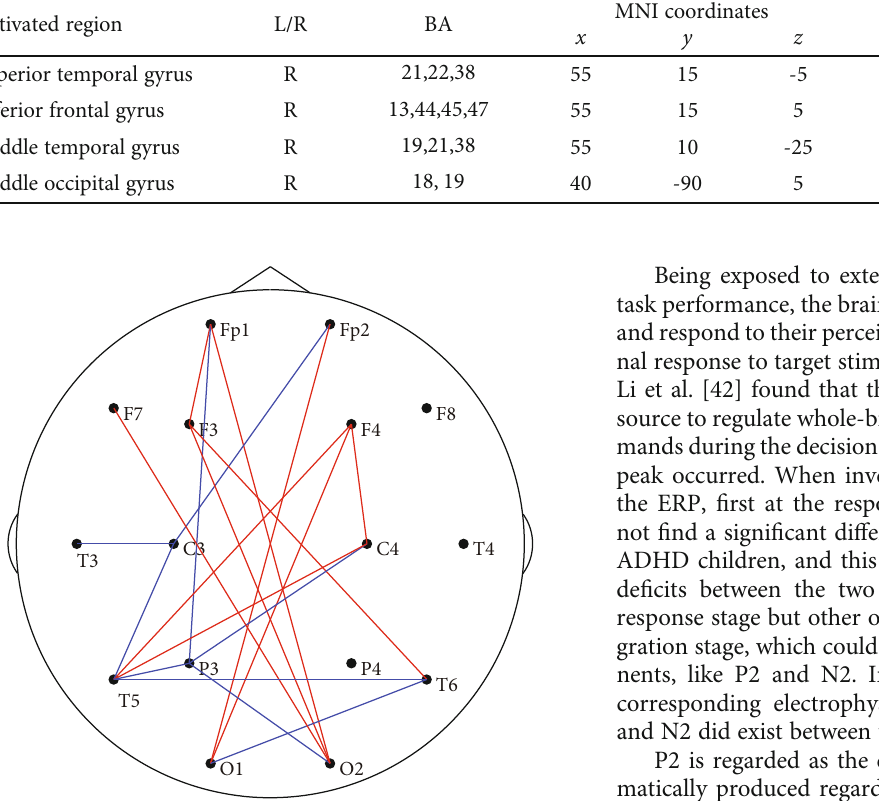
Figure 4: Di ff erentiated brain topology between the HCs and ADHD children; the red and blue solid lines denote the stronger and weaker functional connectivity in ADHD children, respectively, when compared to